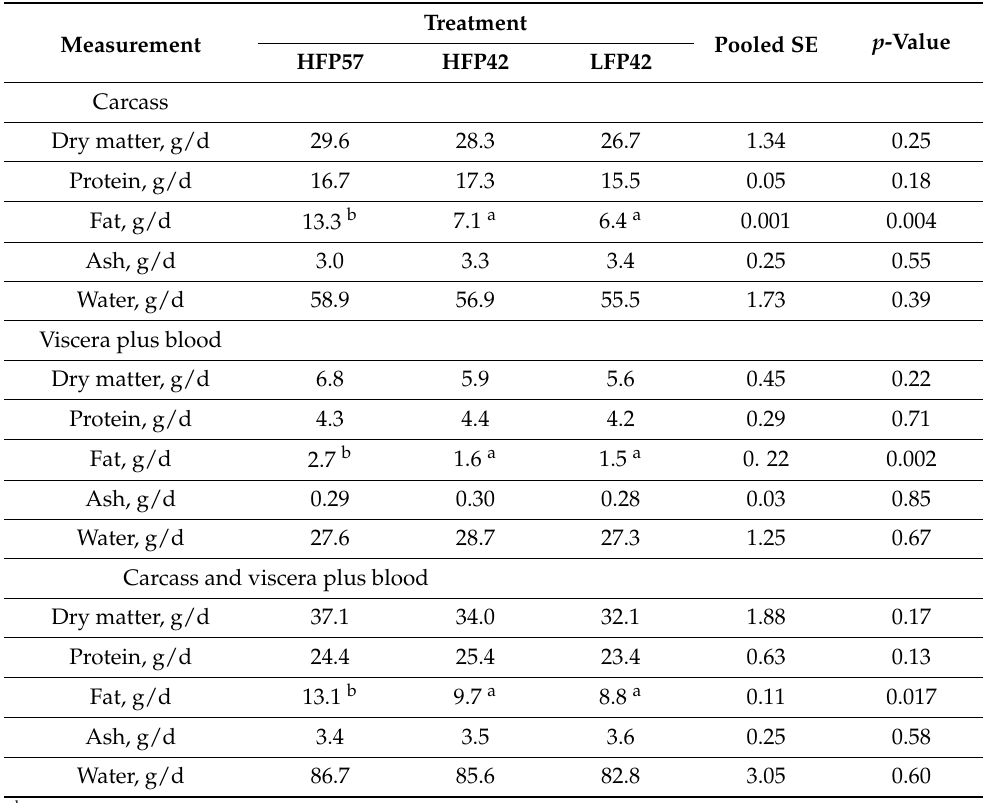
Table 8. Dry matter, protein, fat, ash and water deposition rates in the carcass, viscera plus blood and the whole body of lambs reared artificially using three different rearing regimens: HFP57, commercial milk replacer, high fibre concentrate pellets and milk feeding to 57 days of age; HFP42, commercial milk replacer, high fibre concentrate pellets and early weaning at 42 days of age; LFP42, high protein milk replacer from 2–16 days of age followed by commercial milk replacer, low fibre concentrate pellets and early weaning at 42 days of age. Treatment Measurement Pooled